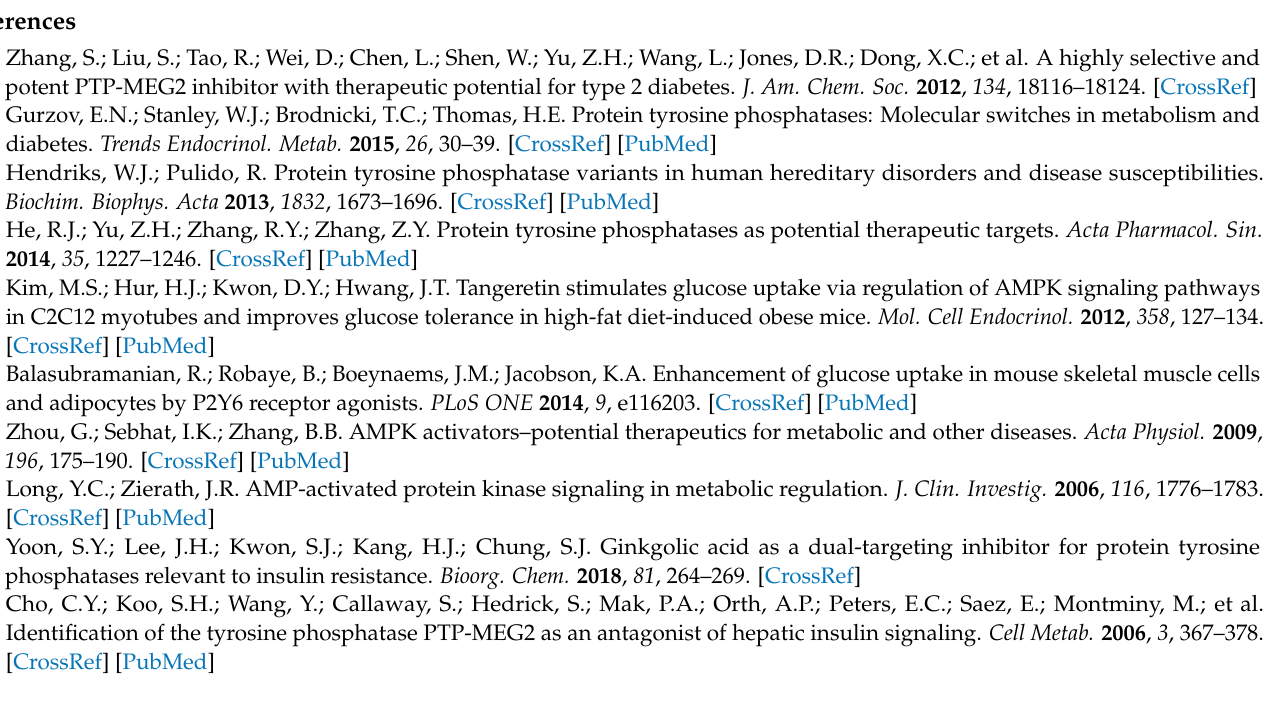
Supplementary Materials: Figure S1: Rosiglitazone and metformin do not inhibit the catalytic activity of PTP-MEG2, Figure S2: GLUT4 translocation was increased by 10 µ M phloridzin. Table S1: Primer sequences used to target mouse genes, Table S2: Kinetic constants for DiFMUP hydrolysis by